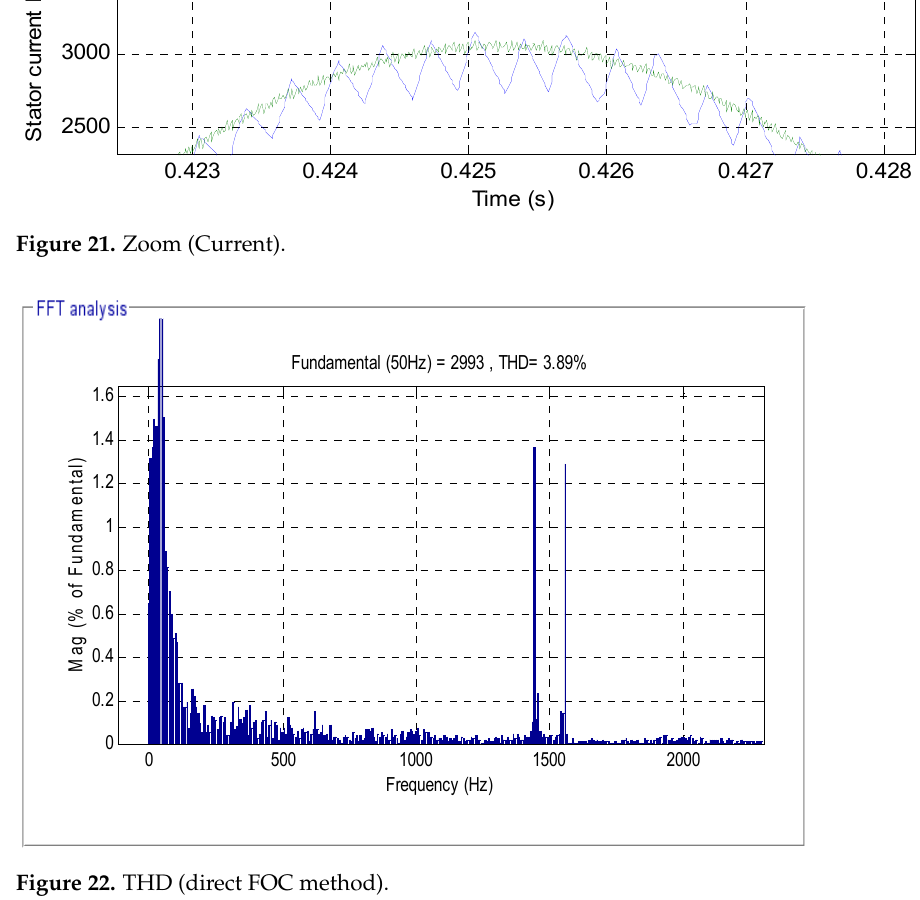
Figure 22. THD (direct FOC method).